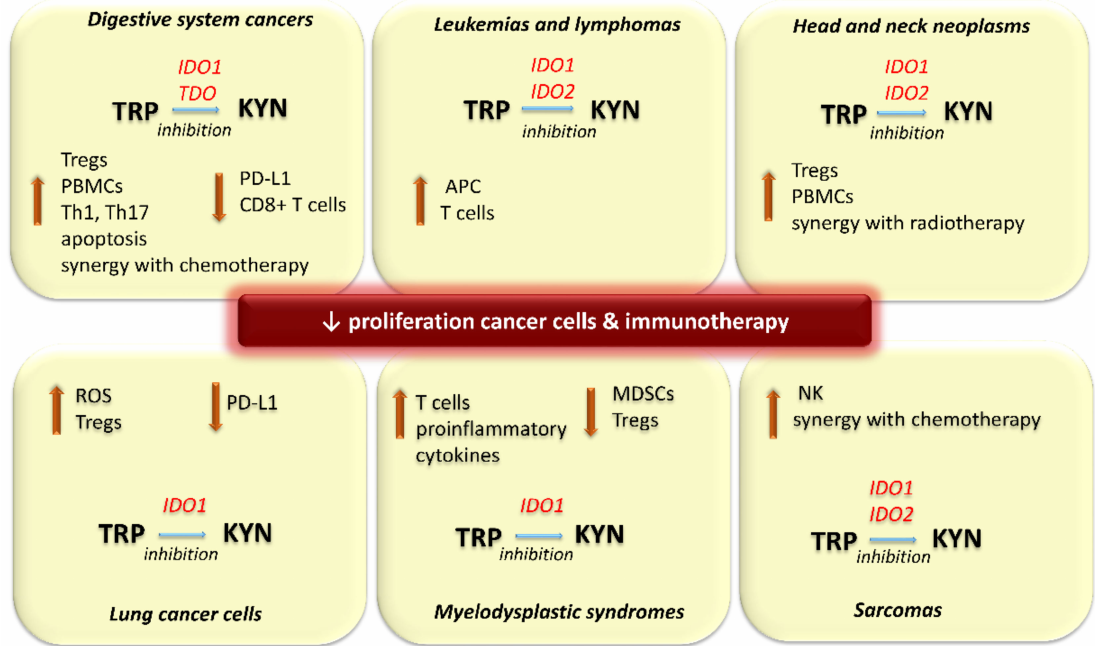
Figure 3. Effects of inhibition of 2,3-dioxygenases activity in selected types of cancers. APC: antigen presenting cells, CD8+ T cells: cytotoxic T cells IDO: indoleamine 2,3-dioxygenase, KYN: kynurenine, MDSCs: myeloid-derived suppressor cells, NK: natural killer cells, PBMCs: peripheral blood mononuclear cells, PD-L1: programmed cell death protein-1 ligand, ROS: reactive oxygen species, TDO: tryptophan 2,3-dioxygenase, Th: Helper T cells, TRP: tryptophan, Tregs: T regulatory